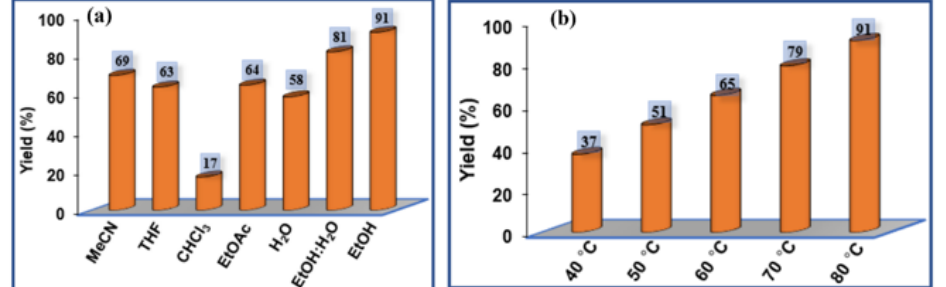
Figure 17. ( a ) Effect of the solvent on the yield of 2,4,5-triphenyl-1 H -imidazole in one-pot MCR. ( b )